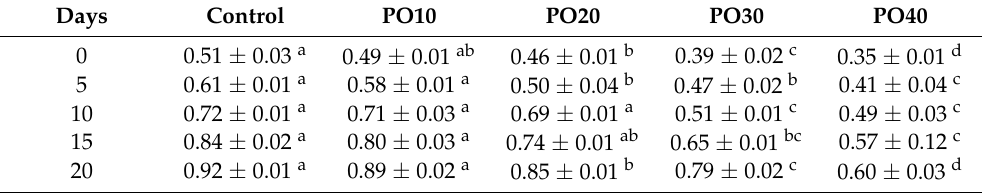
Table 8. The TBARs value of Pleurotus ostreatus (PO) pork sausages during storage